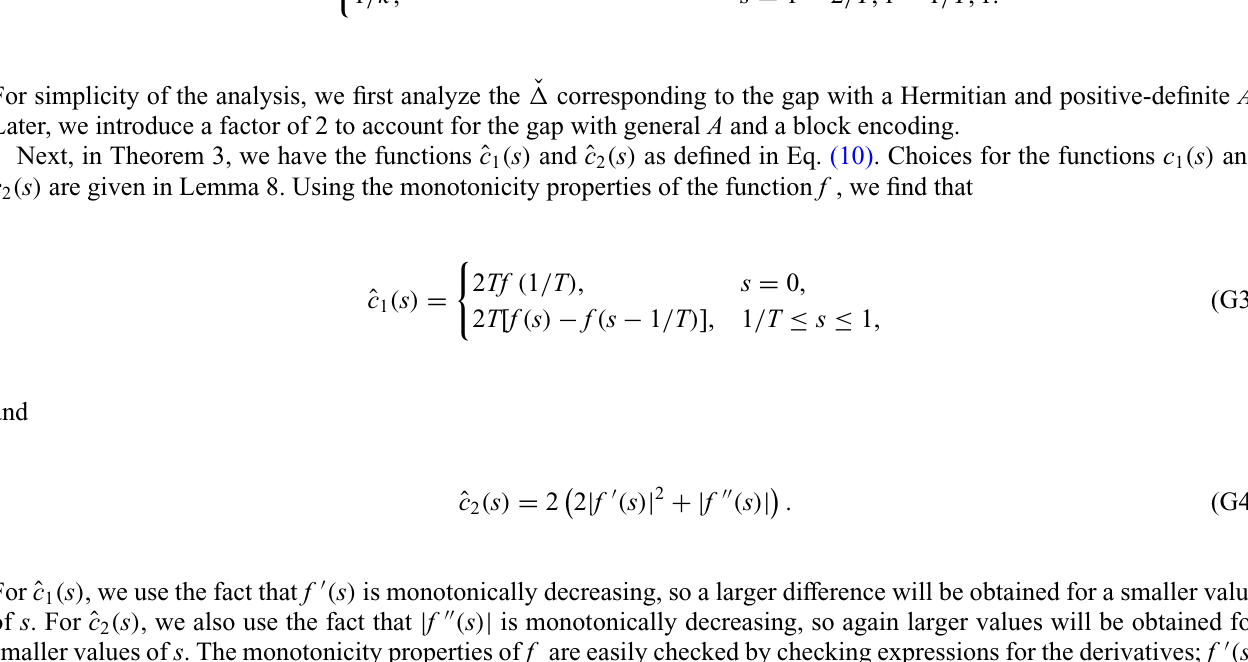
FIG. 9. The block encoding of the Hamiltonian H ( s ) , where the target system is labeled as | ψ (cid:2) and the ancillas are labeled a 1 – a 4 and a (where a is the ancilla needed in the block encoding of A ). The dashed boxes show CU 1 show CR 0 ( s ) . The σ x on ancilla a 4 has been moved to the middle, so the operations CU 0 CR 0 ( s )